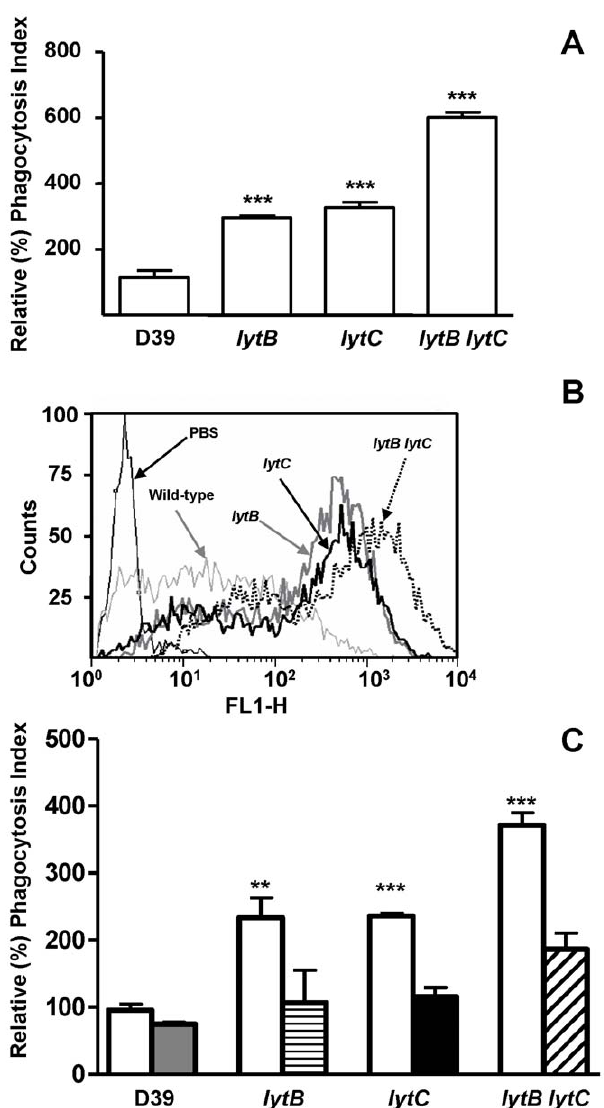
Figure 5. Opsonophagocytosis mediated by human neutro- phils using a flow cytometry assay. (A) Phagocytosis of D39 strain and lytB , lytC and lytB lytC strains incubated in 20% human serum and expressed as percent fluorescent indices relative to the results for the wild-type D39 strain. (B) Example of a flow cytometry histogram for phagocytosis. (C) Restoration of the levels of phagocytosis of lytB , lytC and lytB lytC mutants in the presence of 2 m ]g of the indicated purified CWHs. Open bars represent phagocytosis without addition of proteins. Grey bar shows phagocytosis of wild-type strain in the presence of LytB and LytC proteins. Striped, blackened, and hatched bars indicate, respectively, phagocytosis of lytB , lytC , or lytB lytC mutants in the presence of LytB, LytC, or a mixture of both proteins, respectively. Error bars represent SDs and asterisks represent statistical significance compared to the wild-type strain (two-tailed Student’s t test; *, P , 0.05; **, P , 0.01; ***, P , 0.001). P , 0.0001 for the overall comparison in phagocytosis (one-way ANOVA with a post hoc Dunnett test). For the comparison of the phagocytosis of the different mutant strains compared to the phagocytosis in the presence of exogenous proteins ( P , 0.05 for lytB and P , 0.01 for lytC or lytB lytC mutants). doi:10.1371/journal.pone.0023626.g005 LytB does not have any effect on bacterial virulence within the lung airway compartment (Figs. 7A to C). The CI of lytC vs. the wild-type strain was significantly reduced in BALF and lung